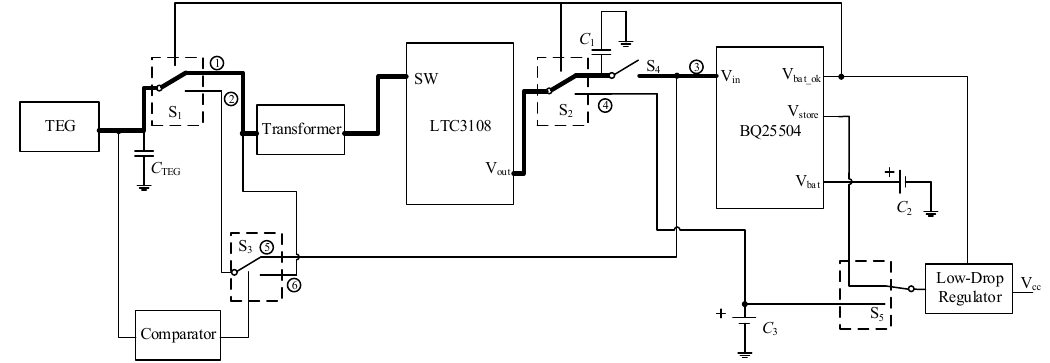
Figure 3. The start-up period working principle of proposed PMS.